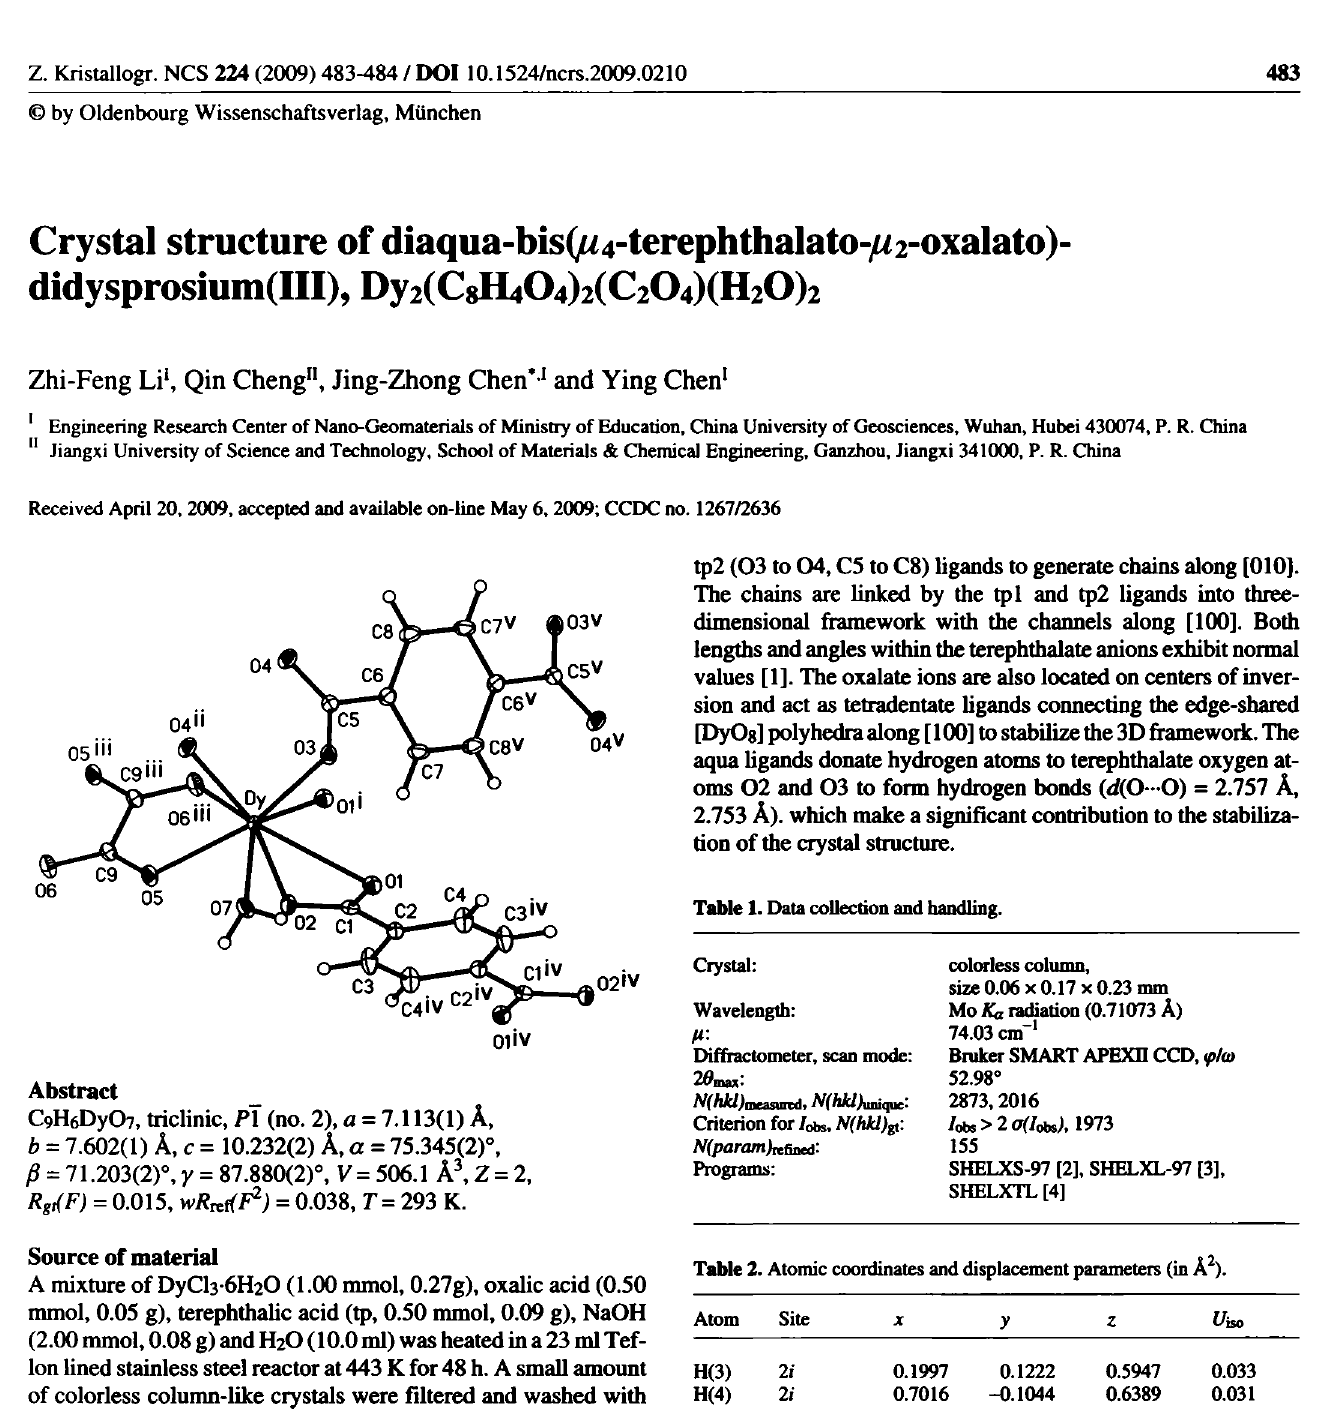
Table 2. Atomic coordinates and displacement parameters (in Â 2